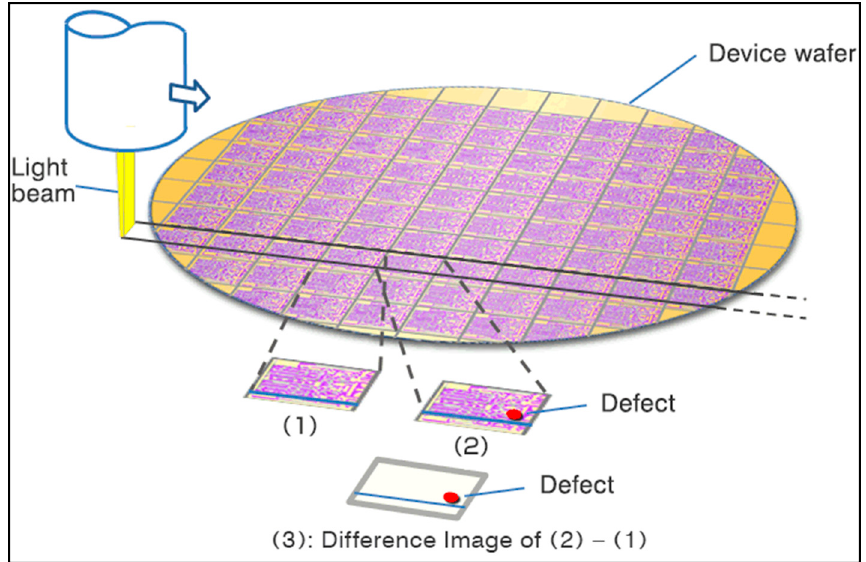
Figure 2. Principles of defect detection on a patterned wafer; a die-to-die image comparison principle is used to detect the defects.